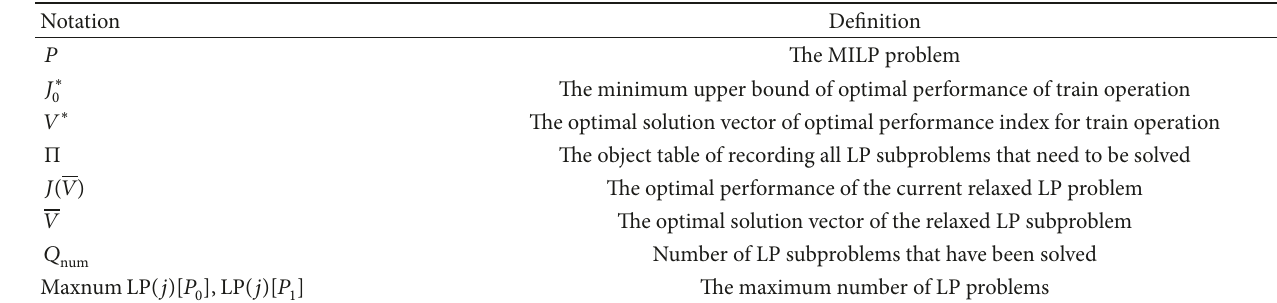
Table 4: Definition of some